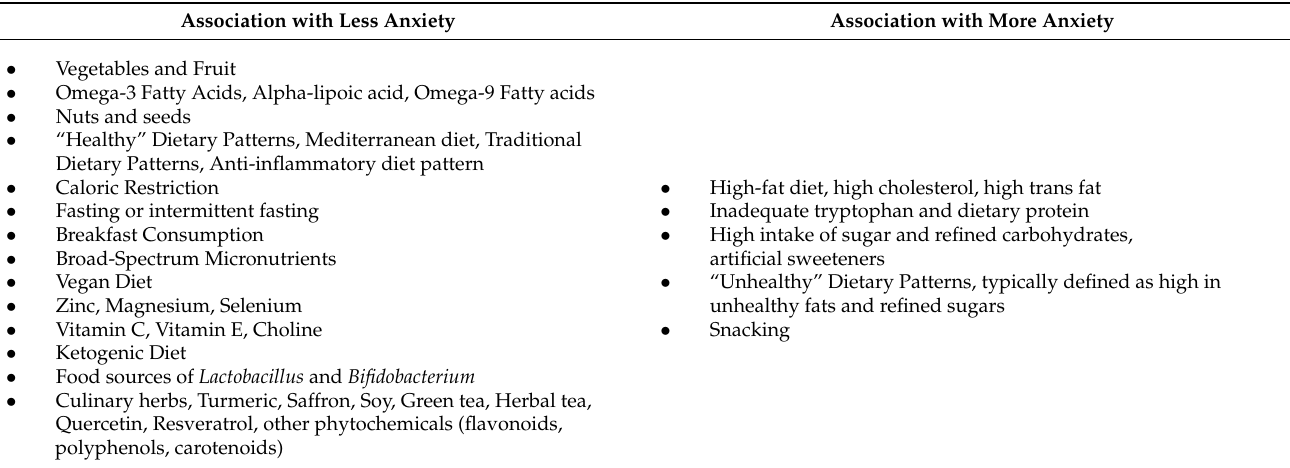
Table 1. Summary of nutrients and diet patterns associated with more or less anxiety symptom severity or disorder prevalence. Association with Less